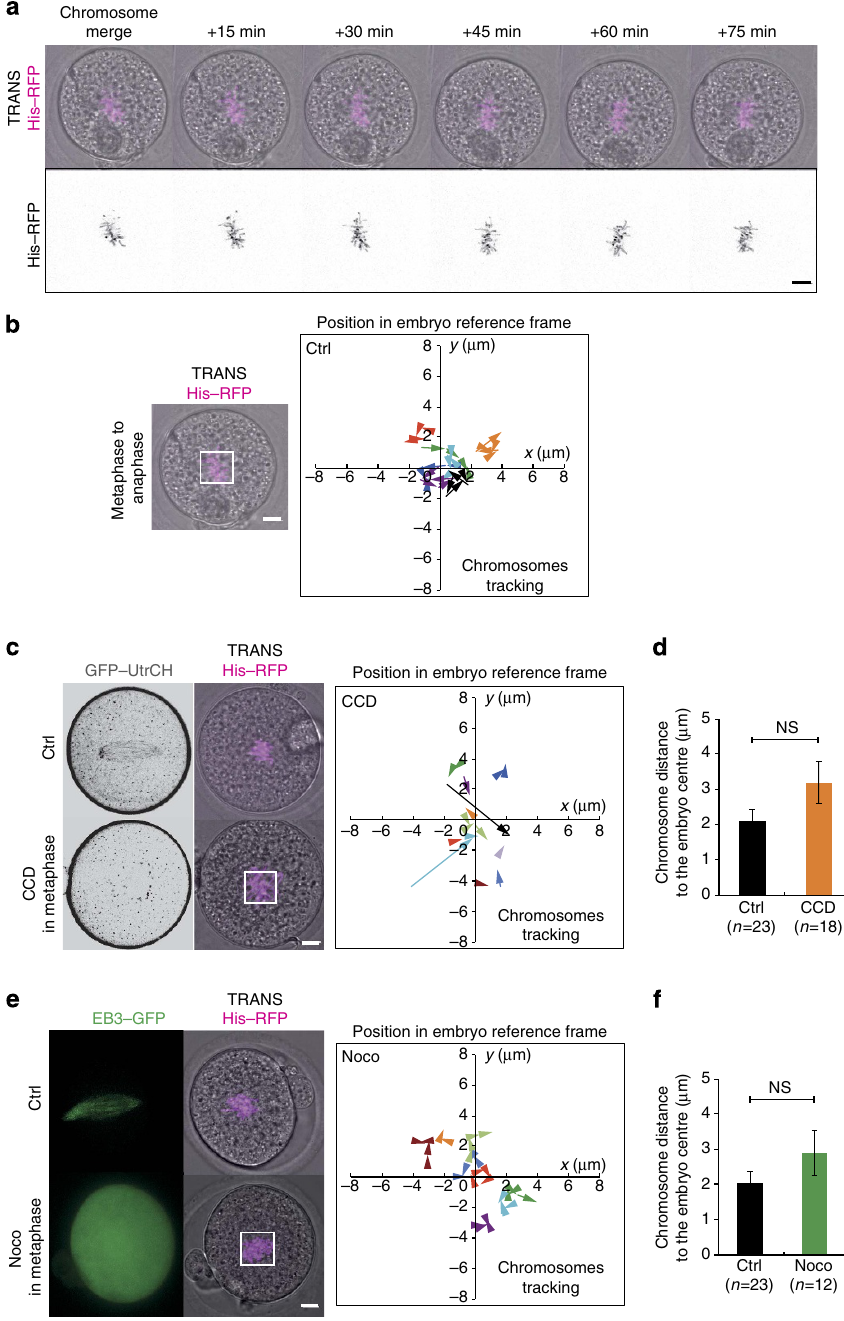
Figure 7 | Maintenance of the central position of the metaphase plate is actin and microtubule independent. ( a ) Control embryo expressing His–RFP (purple or black, Z-projection over 20 m m). One picture is shown every 15min. Scale bar, 10 m m). ( b ) Left panel: Control embryo expressing His–RFP (purple, Z-projection over 20 m m) after chromosome merging. Scale bar, 10 m m. Right panel: graph showing the position of the centroid of the chromosomes in the referential of the embryo (0 being the centre) from metaphase to anaphase for representative control embryos. The scale is represented by the white box on the left panel. Each colour represents an embryo. The arrows point to the last position recorded before anaphase. One time point is shown every 15 or 20min. ( c ) Left panel: control metaphase embryo (upper panel) and embryo treated with 1 m gml (cid:2) 1 Cytochalasin D (CCD) in metaphase (lower panel) expressing GFP–UtrCH (black, one Z-plane is shown) and His–RFP (purple, Z-projection over 20 m m). Scale bar, 10 m m. Right panel: Same as b for embryos treated with CCD in metaphase. ( d ) Bar graph showing the chromosome mass distance to the embryo centre in metaphase for controls (black bar) and embryos treated with CCD in metaphase (orange bar). Mean is shown of 23 controls and 18 CCD-treated embryos from 2 independent experiments. s.e.m. is plotted on each bar. Statistical significance of differences is assessed with a Mann–Whitney test ( P value 0.204). ( e ) Left panel: control metaphase embryo (upper panel, same as in Fig. 4a) and embryo treated with 1 m M Nocodazole in metaphase (lower panel) expressing EB3–GFP (green, one Z-plane is shown) and His–RFP (purple, Z-projection over 20 m m). Scale bar, 10 m m. Right panel: Same as b for embryos treated with 1 m M Nocodazole in metaphase. ( f ) Bar graph showing the chromosome mass distance to the embryo centre in metaphase for controls (black bar) and embryos treated with Nocodazole in metaphase (green bar). Mean is shown of 23 controls and 12 Nocodazole-treated embryos from 2 independent experiments. s.e.m. is plotted on each bar. Statistical significance of differences is assessed with a Mann–Whitney test ( P value